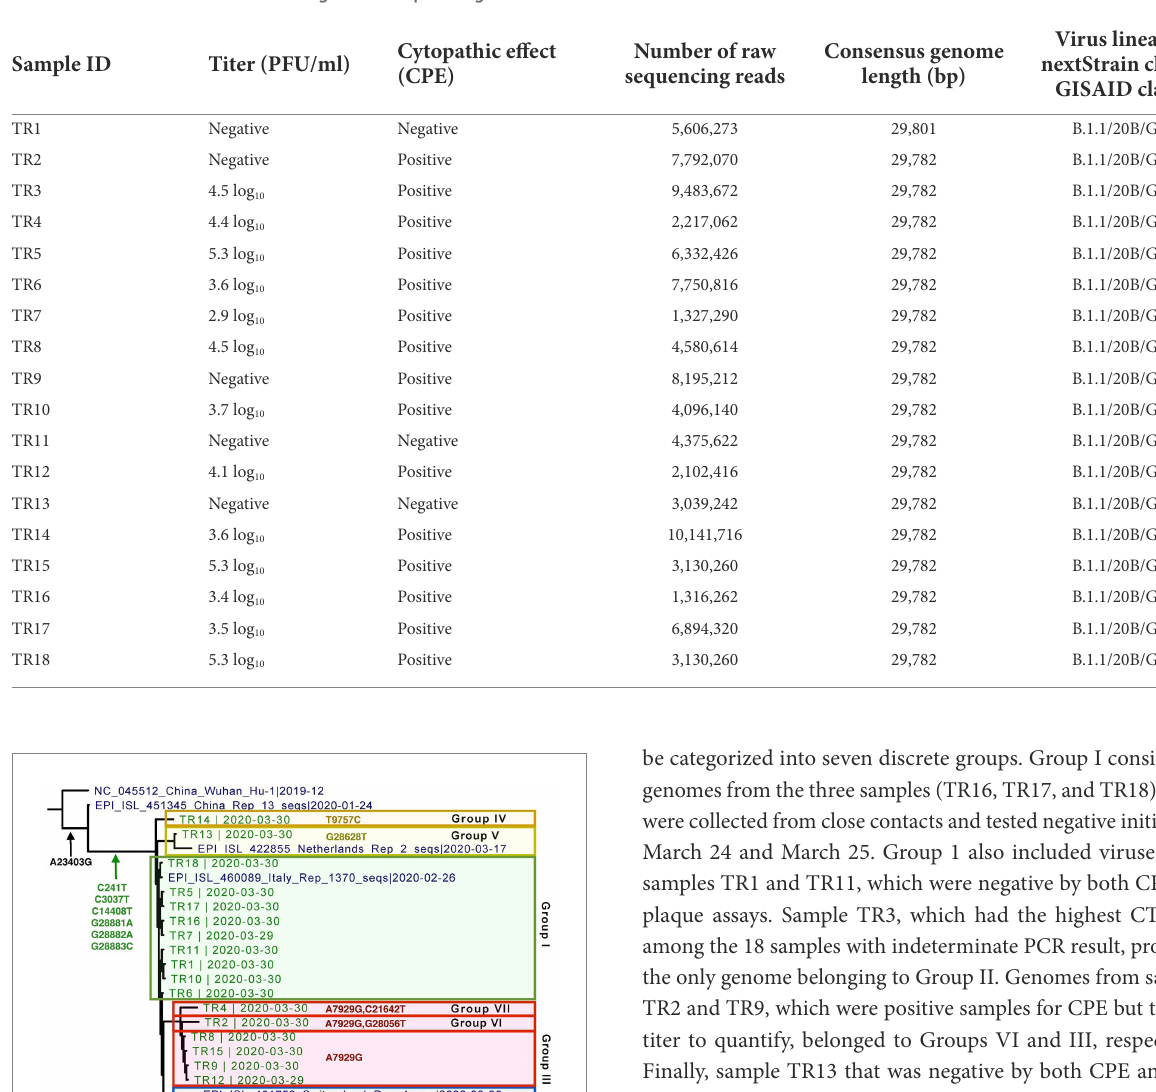
TABLE 2 Virus cultivation results and genome sequencing statistics.